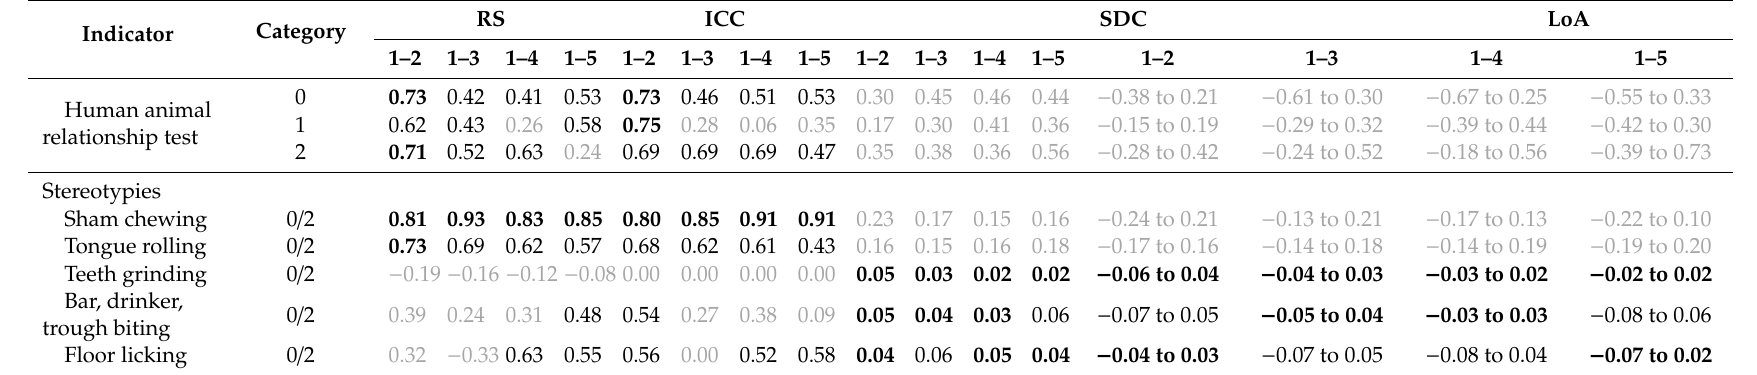
Table 9. Statistical parameters (Spearman’s rank correlation coe ffi cient: RS, intraclass correlation coe ffi cient: ICC, smallest detectable change: SDC, limits of agreement: LoA) for the comparison of the five farm visits (1–5) for the categories of the human − animal relationship test and the categories of the assessment of stereotypies, indicating poor (normal type, gray color), acceptable (normal type, black color), and good (bold type, black color) reliability or agreement,